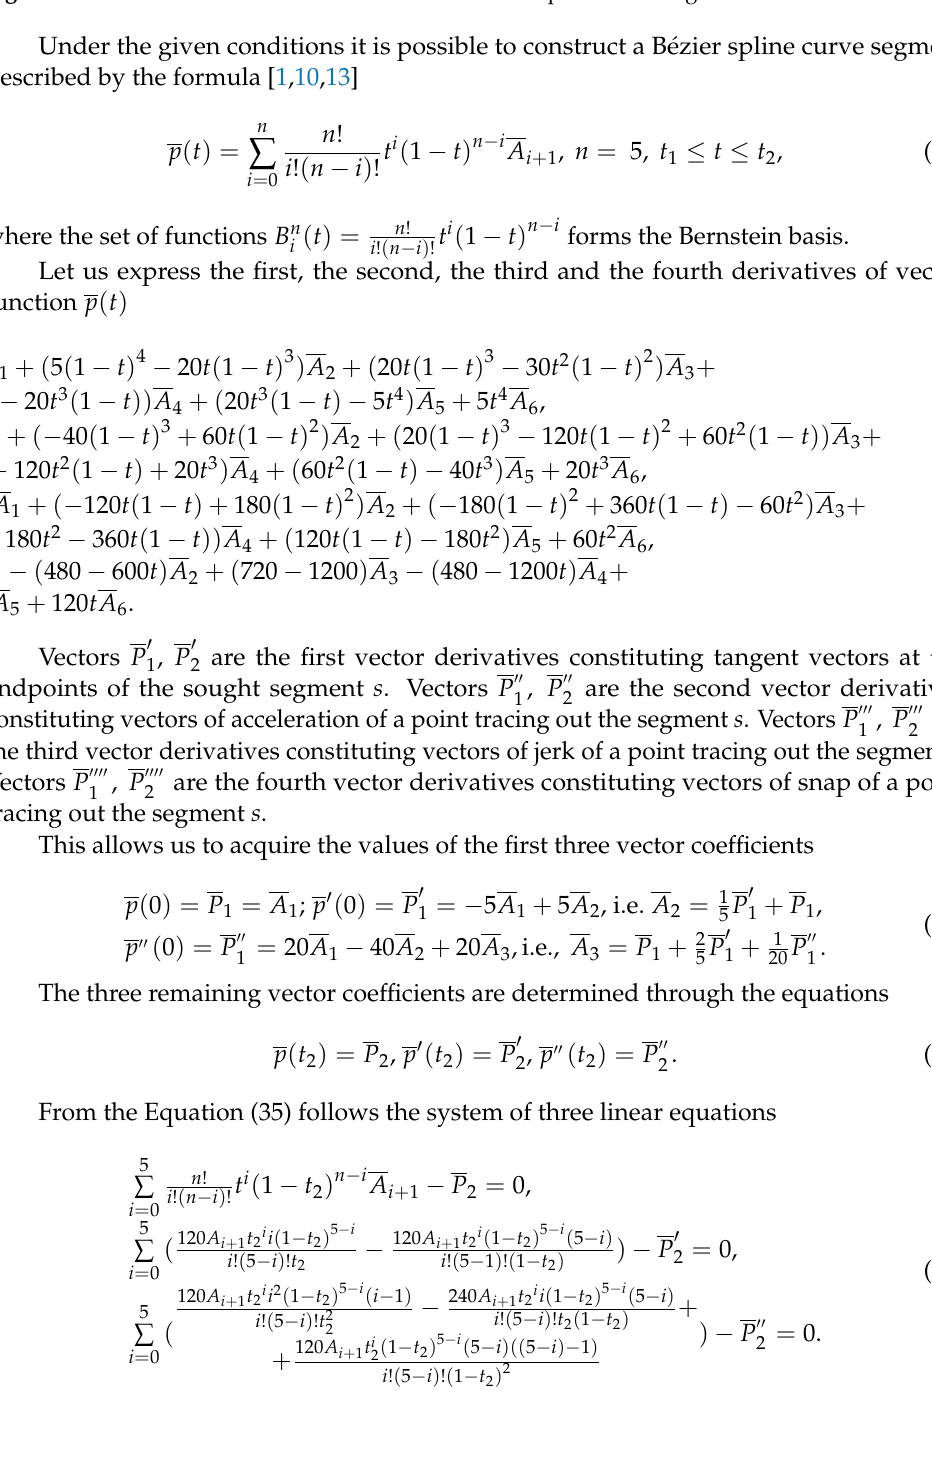
Figure 15. Initial conditions for construction of a Bézier spline curve segment.